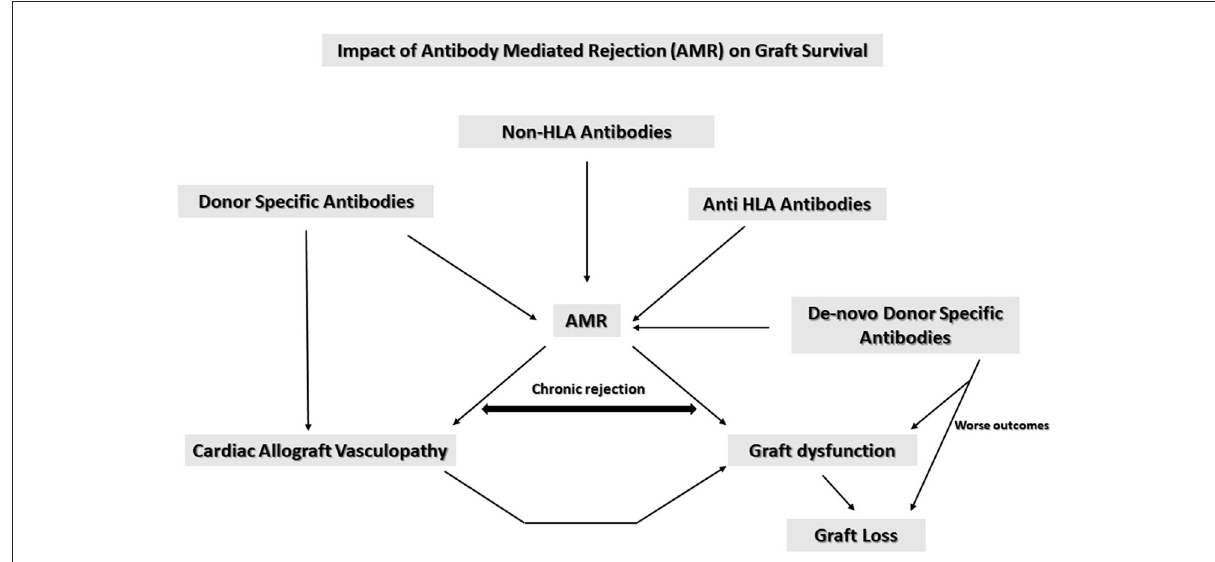
FIGURE1 Impact of antibody mediated rejection on graft